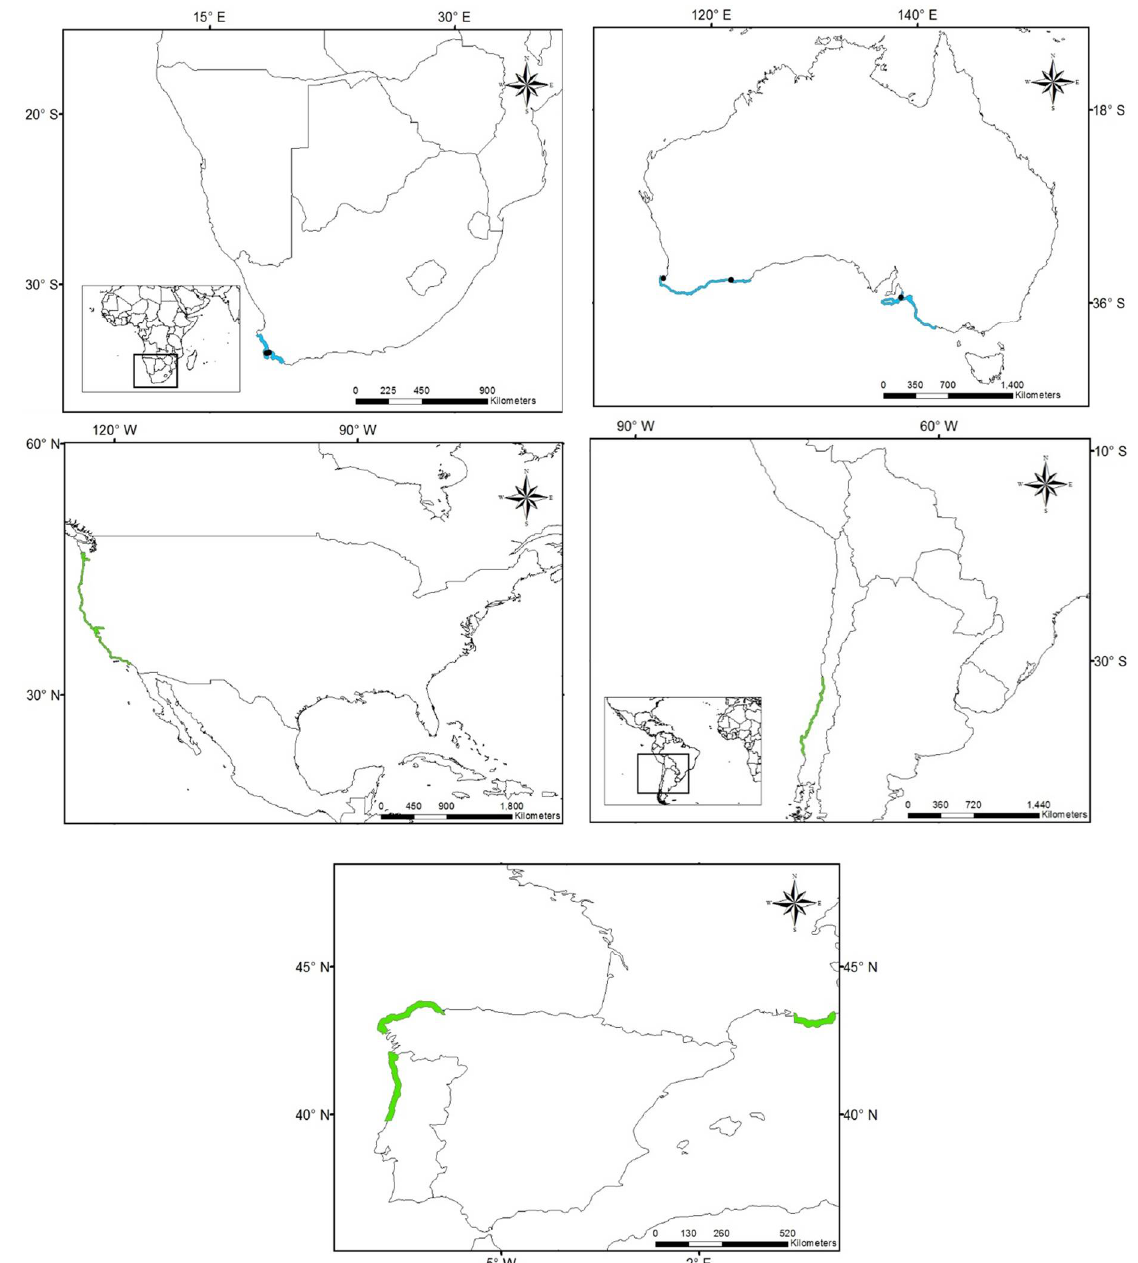
Figure A6. Training (blue) and projection (green) areas for the construction of the models corresponding to Mediterranean warm/cool summer climates (Csb). Black dots represent occurrence records.